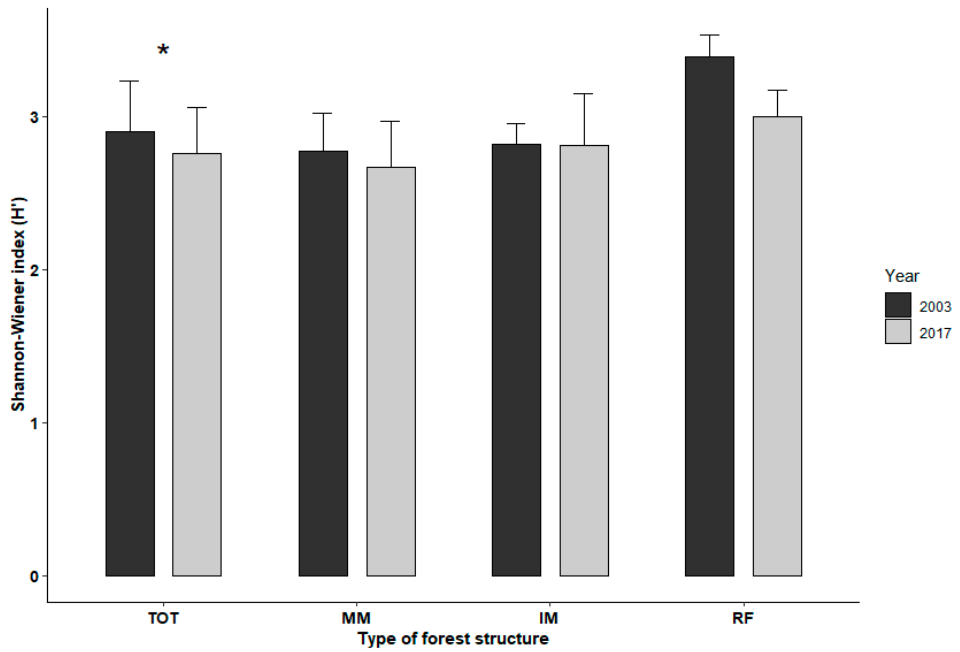
Figure 1. Bar graph comparing average Shannon–Wiener index (H ′ ) values of understory plant communities, calculated for each type of forest structure between the 2003 and 2017 inventories, with standard deviation (SD) depicted as error bars. TOT: total ( N = 20); MM: mature maple ( N = 13); IM: immature maple ( N = 3) RF: reforested ( N = 4). Significant differences between average index values for each year (i.e., p < 0.05), as evaluated by the Wilcoxon paired- t test analysis, are noted by an asterisk (*). No statistical test was conducted on the immature maple and the reforested stands because of their insufficient sample size.